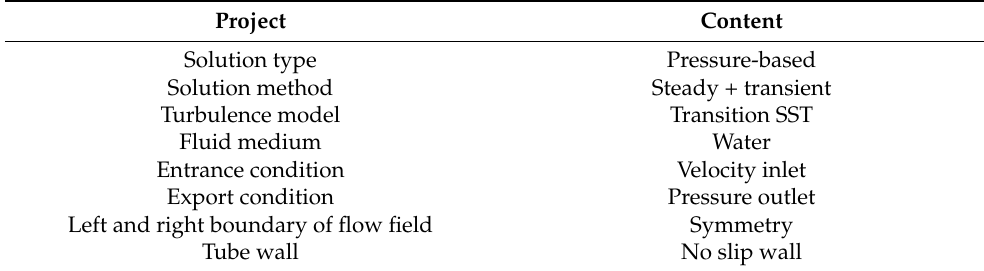
Table 2. Boundary conditions and calculation settings.